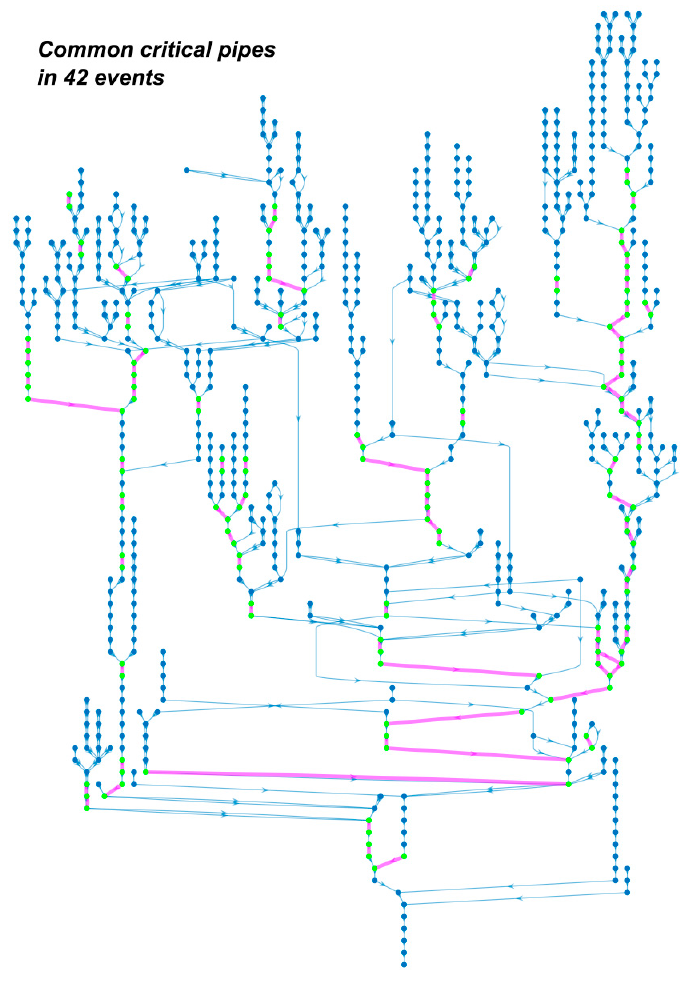
Figure 5. Distribution of critical pipes. Red edges are the critical pipes, and green nodes are the manholes connected to the critical